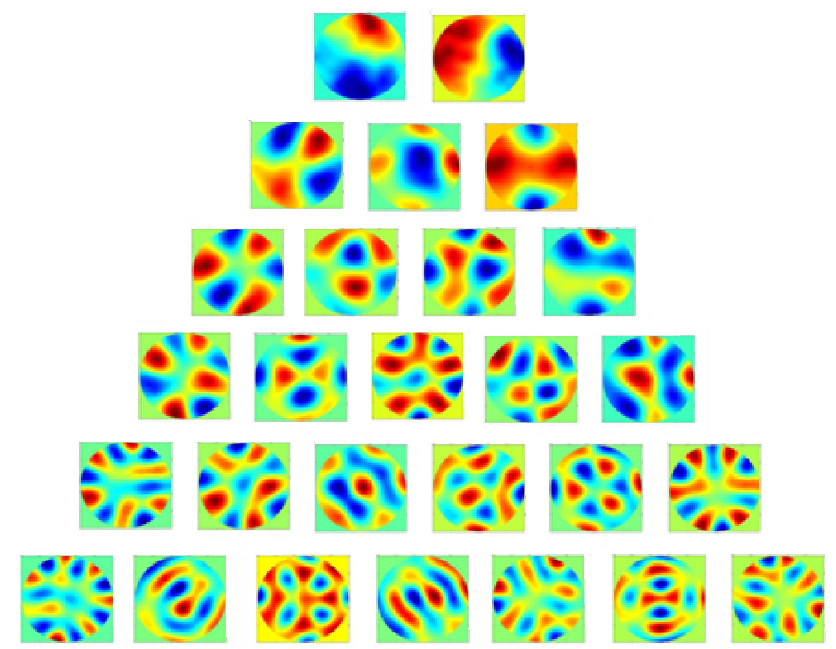
Figure 3. Top 27 eigenmodes’ profiles of the 145-unit DM.